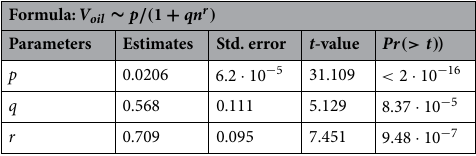
Table 3. Summary of regression analysis